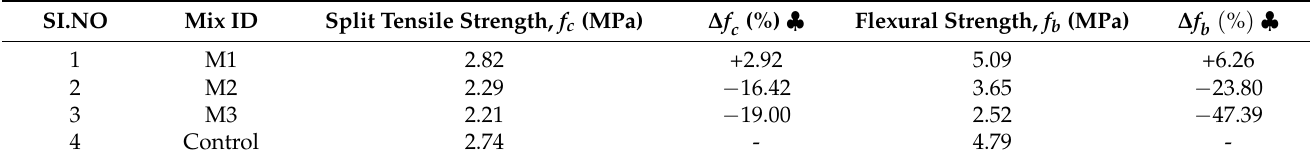
Table 6. Split tensile and flexural strength of concrete at 28 days.